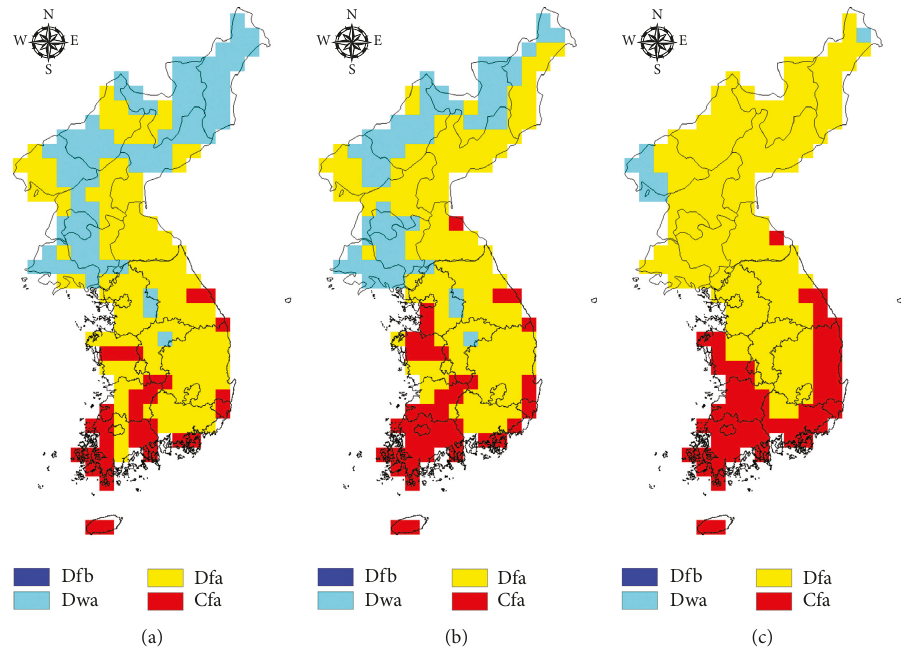
Figure 11: Projection of climatic zones under the RCP 8.5 climate change scenario. (a) Future 1. (b) Future 2. (c) Future 3.